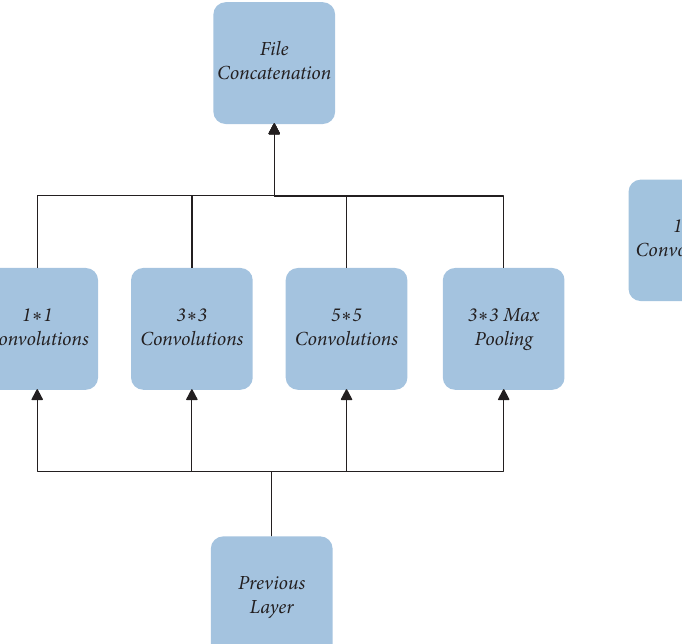
Figure 3: Inception- v 1 module. Figure 4: Inception- v 1 module with less number of